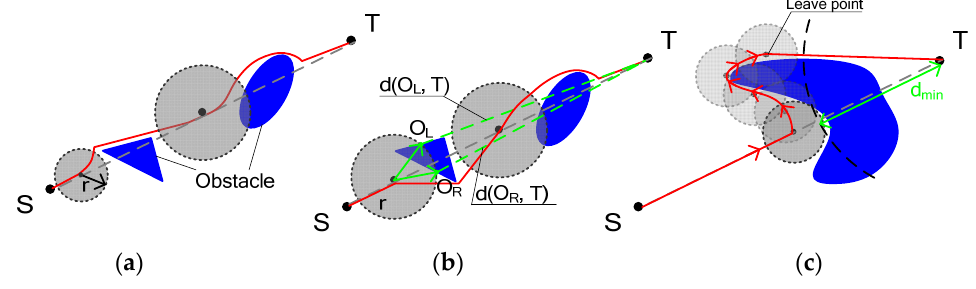
Figure 4. VisBug ( a ) and TangentBug ( b , c ) algorithms.